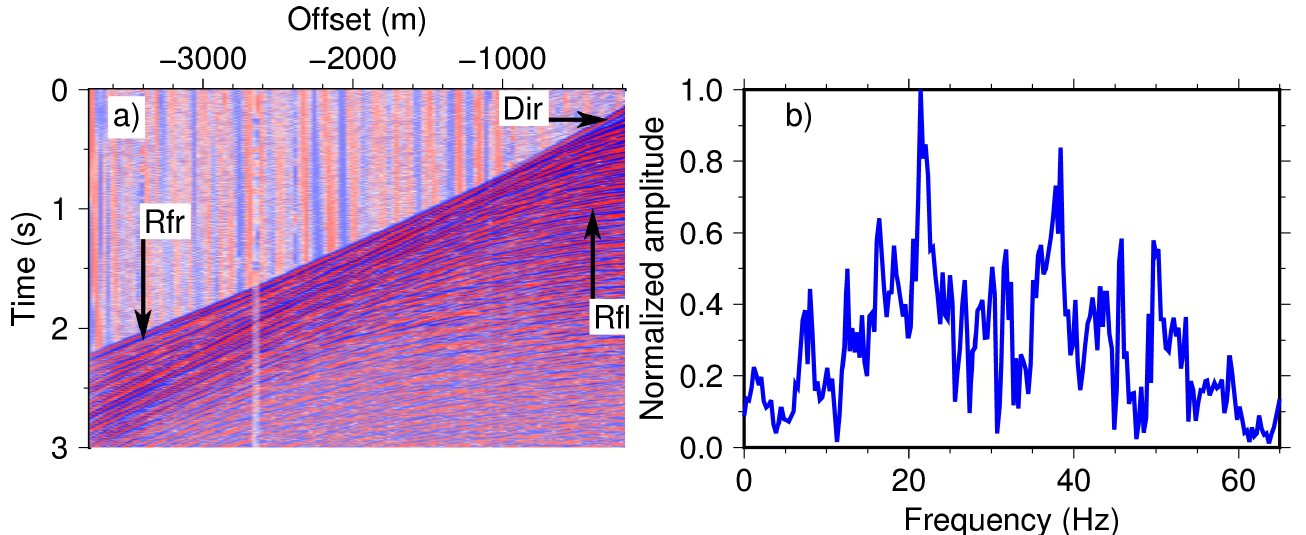
Figure 7. ( a ) Raw shot gather 1500 (corresponds to model distance 4 km) showing the direct arrival (Dir), refraction (Rfr), and reflection (Rfl) events. Time window of 2 s after the first arrival is chosen for inversion. ( b ) Amplitude spectrum of the near–offset trace in the time window 0–3 s. Starting frequency of 6 Hz is used for